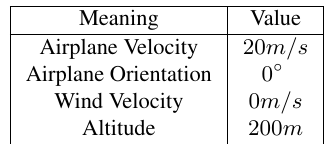
Figure 5: Earth-Relative Aircraft Location